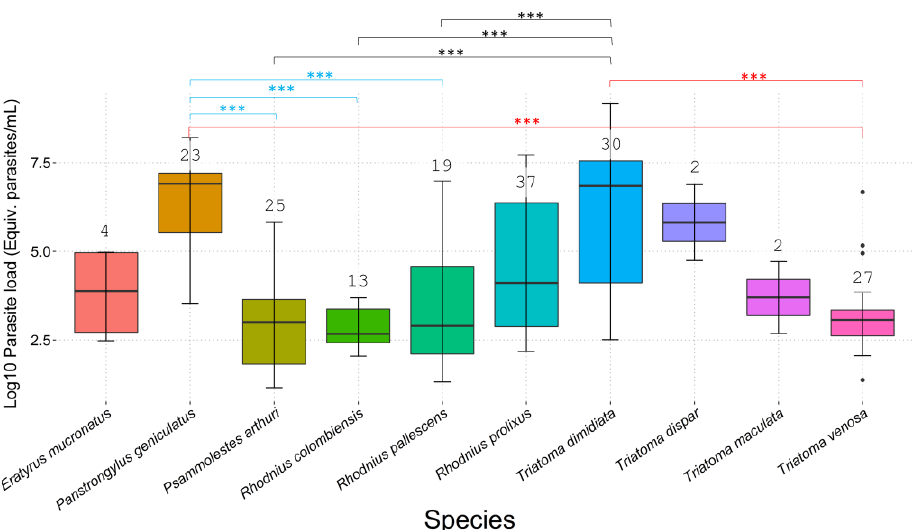
Figure 3. Boxplot of parasitic loads per species. Y -axis was transformed to Log10 scale for better visualization of the data. The number above the boxes is the number of samples per species. Asterisks (***) represent statistically significant comparisons ( p < 0.0001). In blue, P. geniculatus with Ps. arthuri , R. colombiensis, and R. pallescens ; in black, T. dimidiata with Ps. arthuri , R. colombiensis , and R. pallescens ; and in red, T. venosa with P. geniculatus and T. dimidiata .